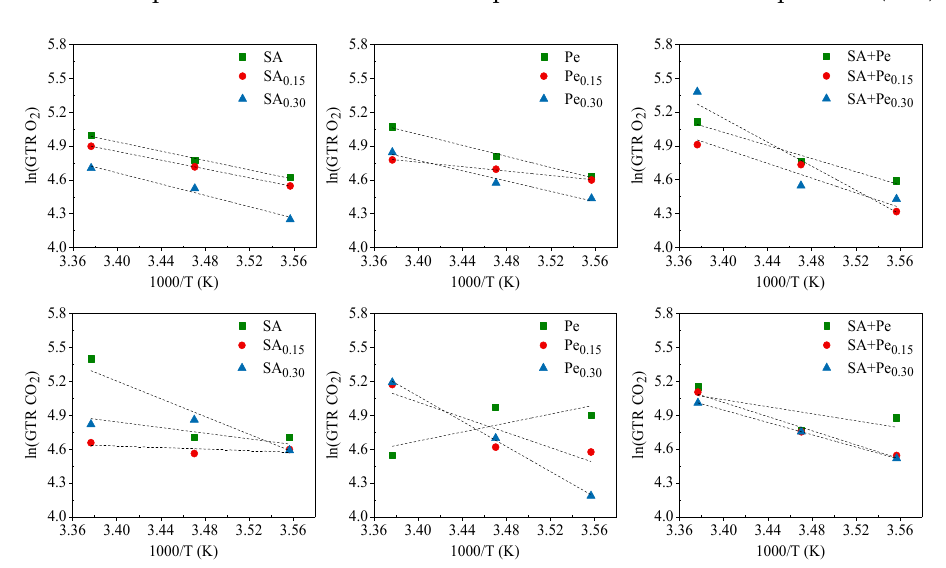
Figure 1. Arrhenius plot of O 2 and CO 2 GTR coefficient for SA, Pe and SA+Pe films.